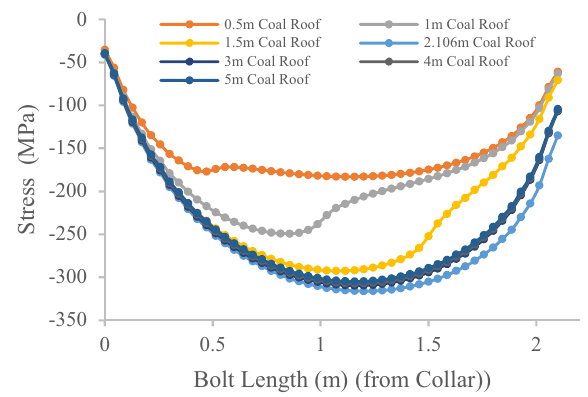
Fig. 7 Stress distribution along 2.1 m fully grouted 22 mm HSAC 840 steel bolt with increasing coal roof